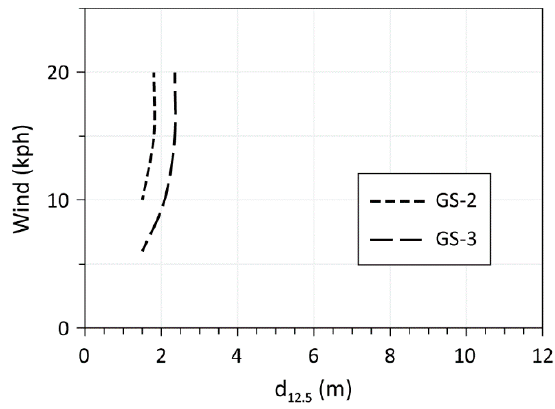
Figure 13. Safe separation distances as a function of wind speed at Moderate MC of live fuel (L3) and variable MC of dead fuel (D2, D3, D4) for each fuel model of GR category: ( a ) GR-2, ( b ) GR-3, ( c ) GR-4.